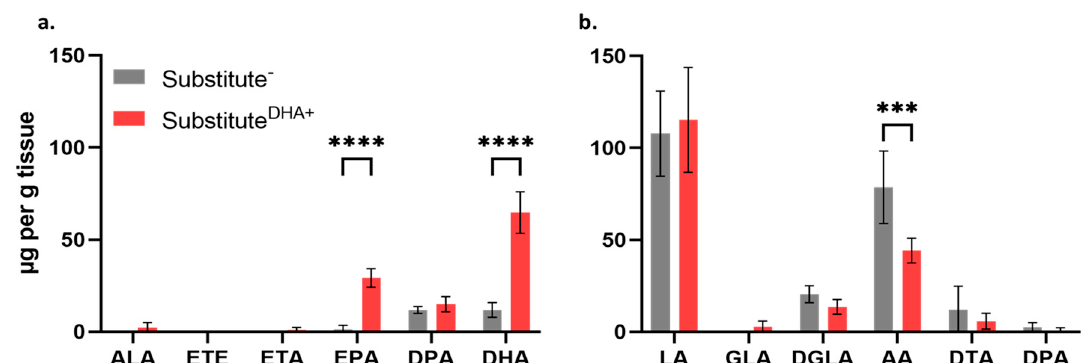
Figure 3. Incorporation of PUFAs in the phospholipid fraction of the epidermis of skin substitutes. Influence of the supplementation of the culture media with DHA on the levels of n-3 and n-6 PUFAs in the epidermal phospholipids of substitutes − and substitutes DHA+ ( a ) n-3 PUFA levels; ( b ) n-6 PUFA levels. PUFAs were quantified by gas chromatography and results are presented as µ g per g of tissue. One-way ANOVA followed by Sidak’s multiple comparison test. (*** p -value < 0.001; **** p -value < 0.0001). Abbreviations: AA, arachidonic acid; ALA, α -linolenic acid; DGLA, dihomo- γ -linolenic acid; DHA, docosahexaenoic acid; DPA, docosapentaenoic acid; DTA, docosatetraenoic acid; EPA, eicosapentaenoic acid; ETA, eicosatetraenoic acid; ETE, eicosatrienoic acid: GLA: γ -linolenic acid; LA, linoleic acid; PUFAs, polyunsaturated fatty acids.